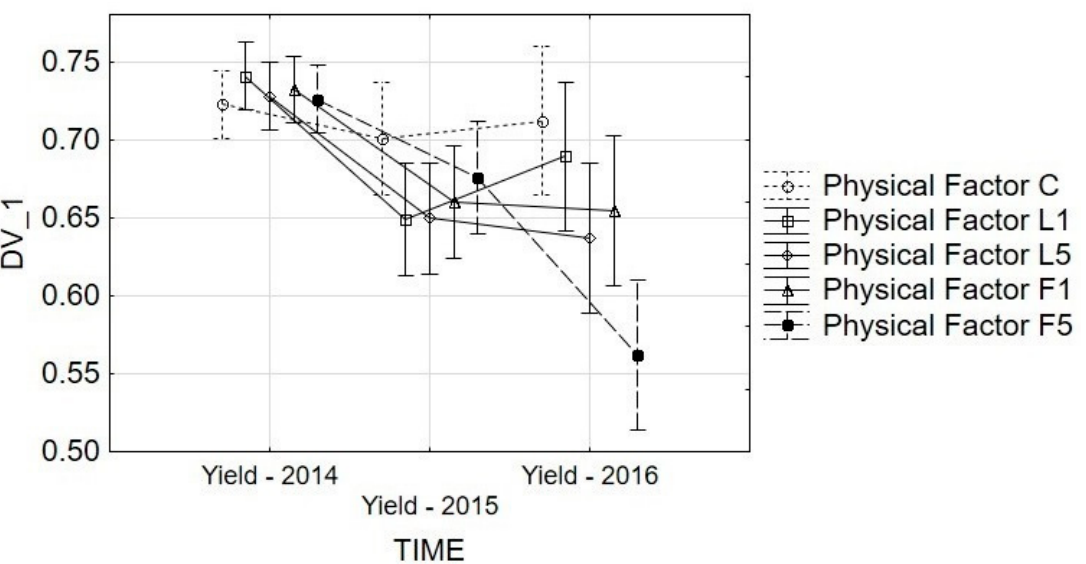
Figure 5. Repeated-measures ANOVA for Yield: interaction graphs for time and physical factor. Vertical bars denote 0.95 confidence intervals. Estimated Marginal Means: TIME*Physical Factor. F(8, 270) = 3.2319, p = 0.00158. C—control; L1—He–Ne laser, exposition time 1 min; L5—He–Ne laser,